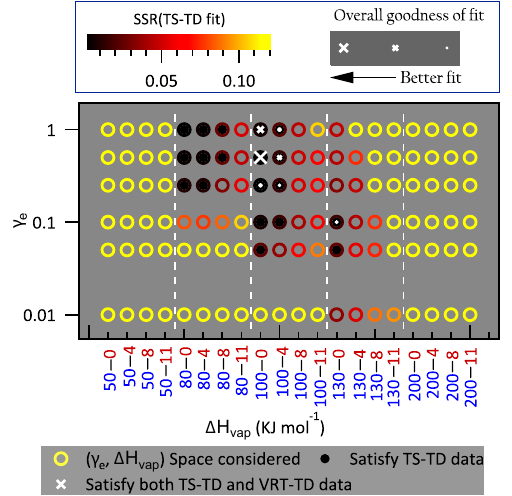
Figure 3. Extraction process of OA gas-particle partitioning param- eter ( (cid:49)H vap , γ e and f i ) values. A f i distribution was solved for each combination of ( (cid:49)H vap , γ e ) via evaporation kinetic model fits to campaign-average dual-TD observations during the Centreville campaign. A relationship of (cid:49)H vap = intercept–slope (log 10 C ∗ @ 298K) was assumed (e.g., 50–0 on x axis represents intercept = 50 and slope = 0). Symbols and colors represent the goodness of fit. Points with filled inner circles recreate TS-TD observations and points with a white cross (x) recreate both TD datasets to within observational variability. Crosses represent the overall goodness of fit including both TS-TD and VRT-TD observations, with larger size corresponding to a better